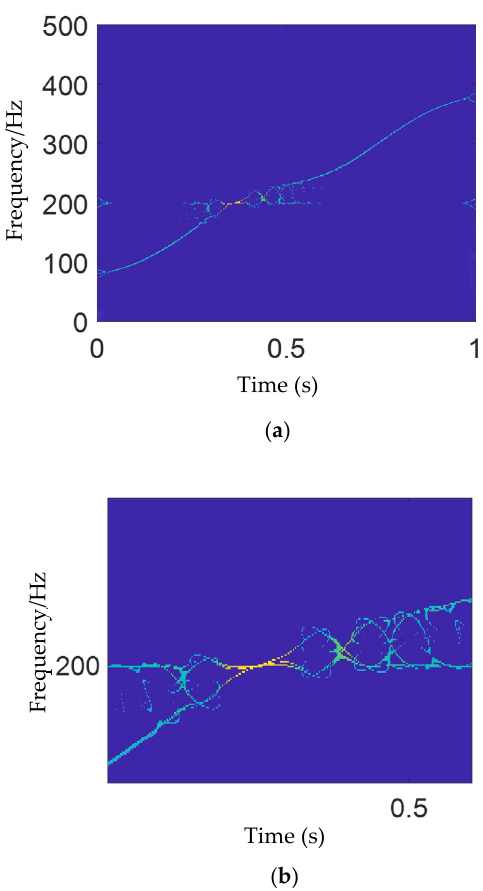
Figure 12. TF distribution of f ( t ) based on SET. ( a ) TF distribution ( b ) Local enlarged figure.